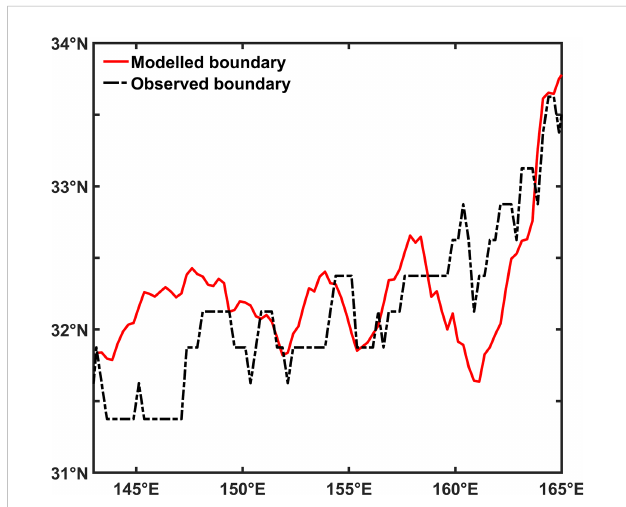
FIGURE 9 The modelled crossing latitude and the observed boundary between bimodality and unimodality at different